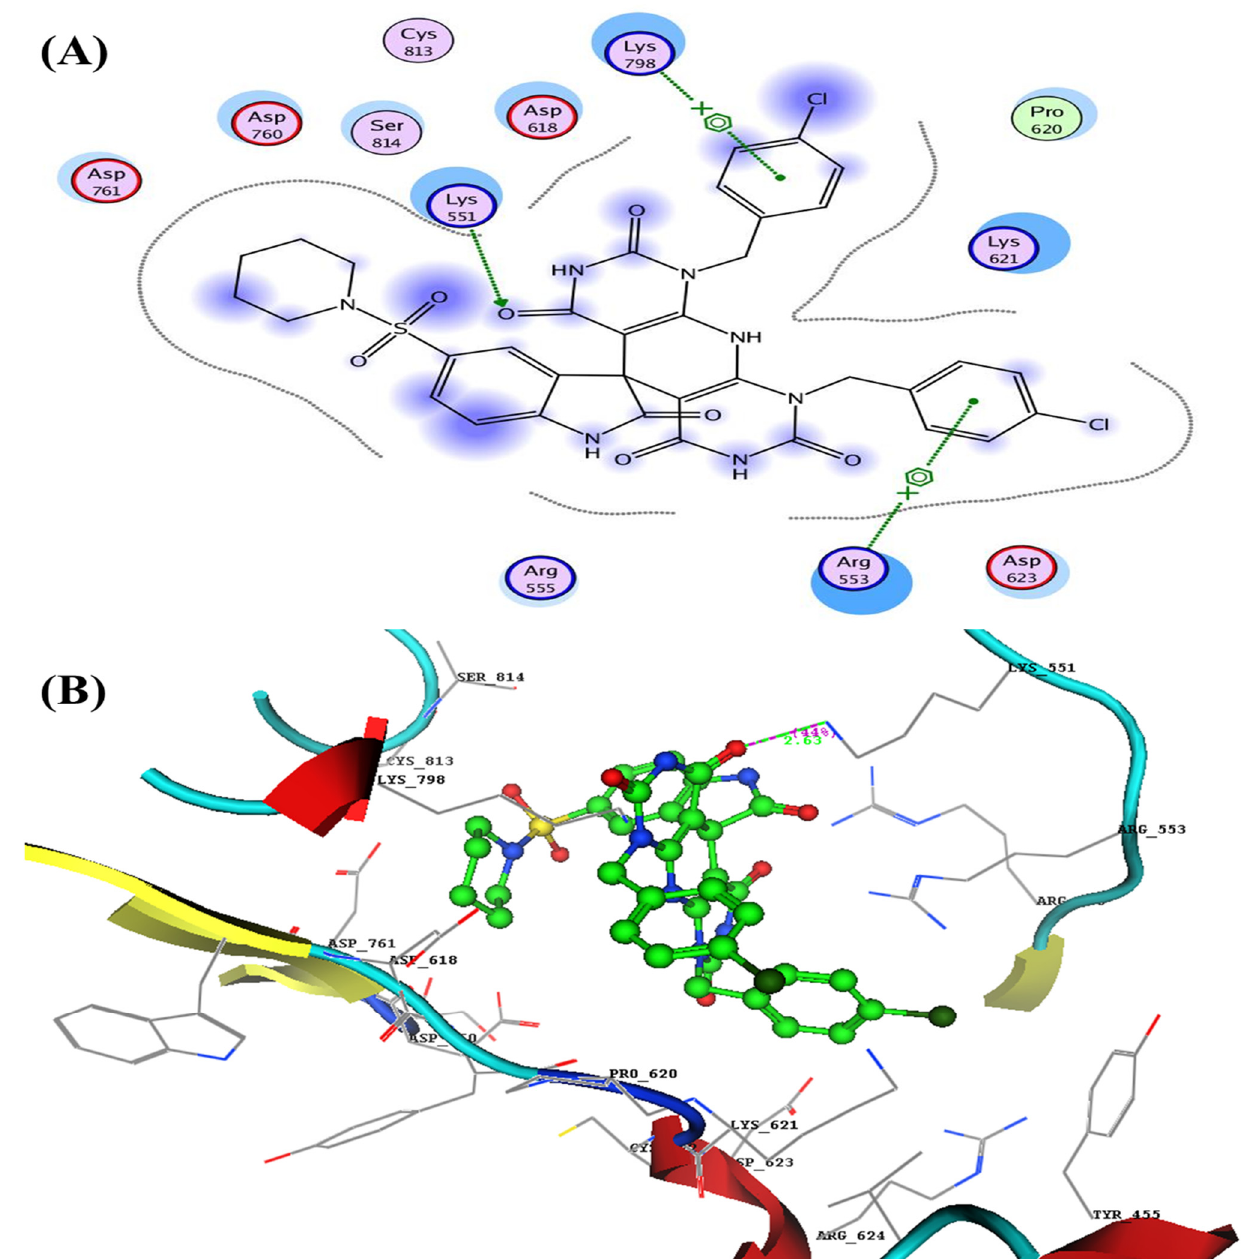
Figure 7. ( A ) 2D and ( B ) 3D structures of compound 4d inside the active site of RNA polymerase (RdRp) (PDB: 6m71).